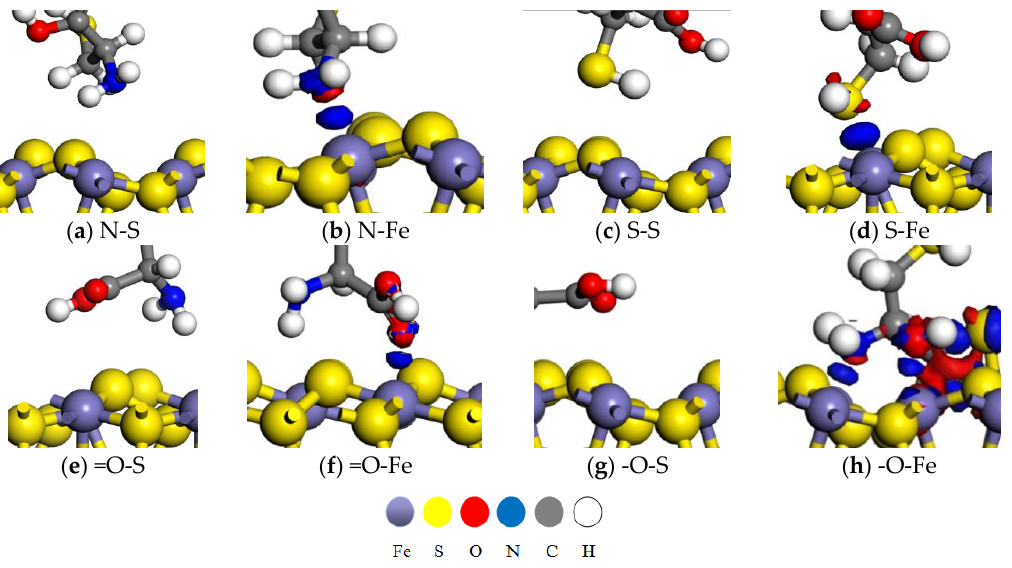
Figure 4. Electron density difference of the interaction between cysteine and pyrite (1 0 0) surface. The red area represents losing electrons, and the blue contours indicate an electron density increase, showing with -NH 3 ( a , b ), -SH ( c , d ), =O (-C=O, ( e , f )), -O (-C-OH, ( g , h )) of cysteine adsorbed on the S/Fe site of pyrite (1 0 0), respectively.